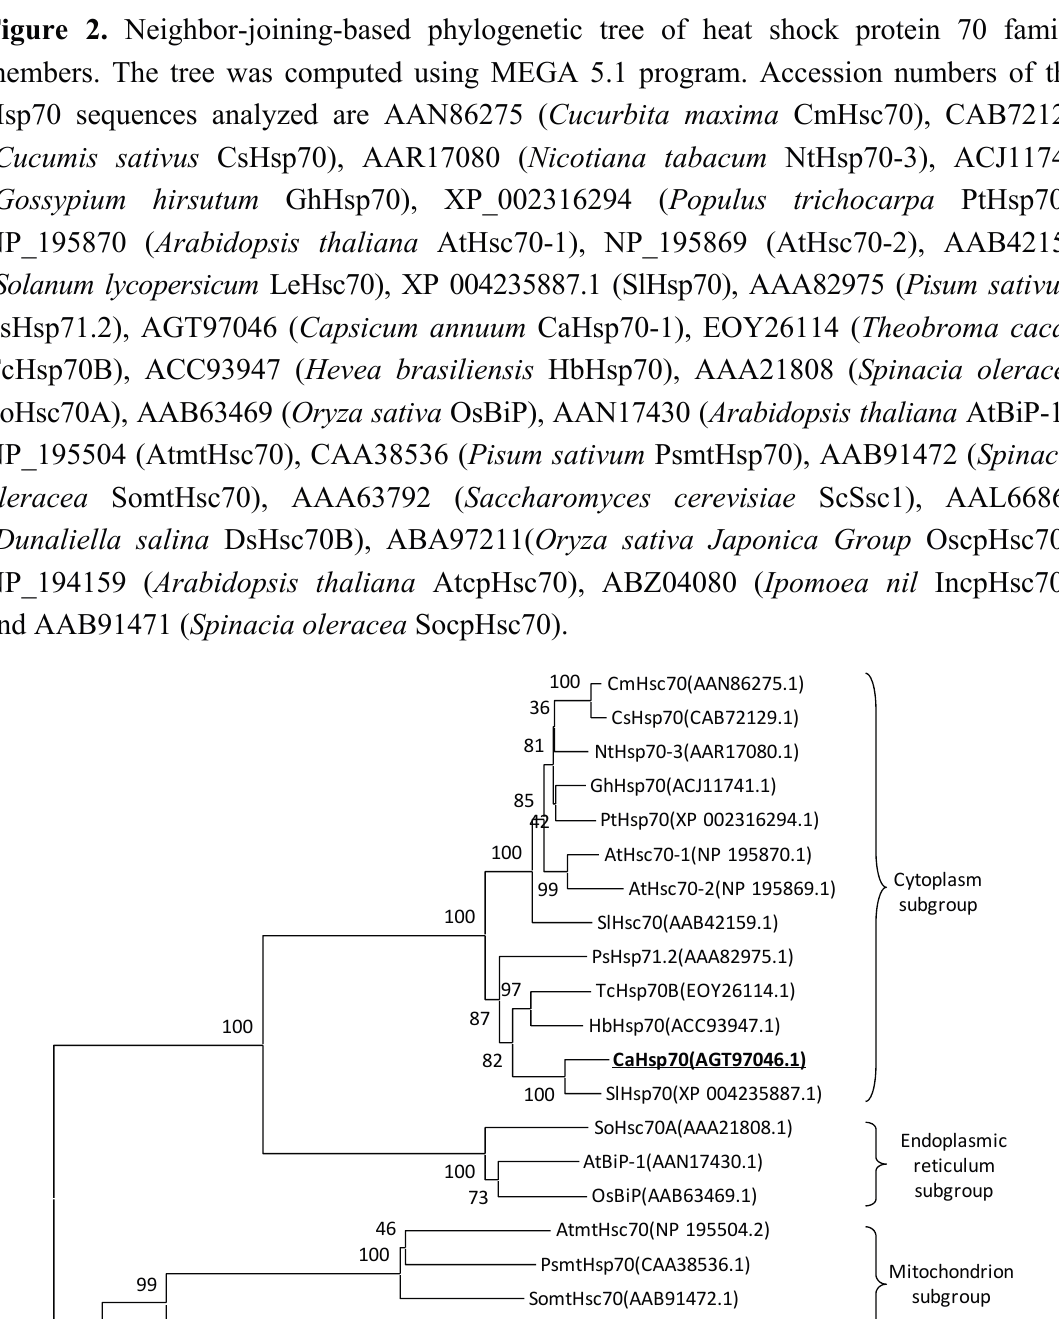
Figure 2. Neighbor-joining-based phylogenetic tree of heat shock protein 70 family members. The tree was computed using MEGA 5.1 program. Accession numbers of the Hsp70 sequences analyzed are AAN86275 ( Cucurbita maxima CmHsc70),